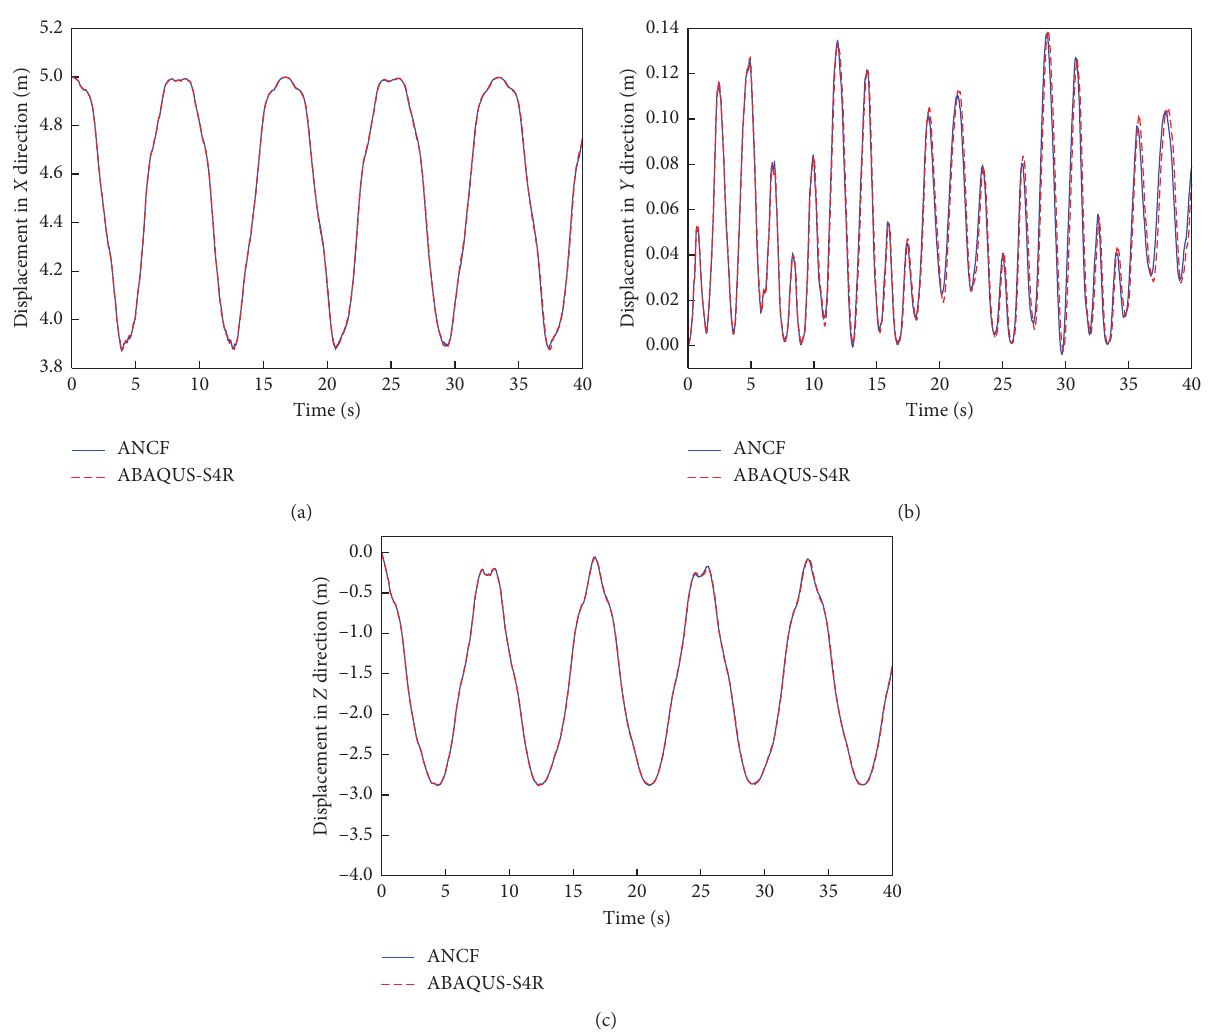
Figure 9: Displacement responses of the cantilever composite laminated